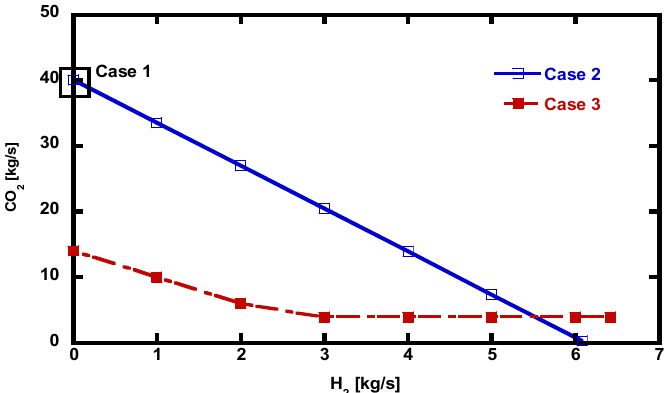
Figure 9. Variation in CO 2 emissions according to H 2 usage.